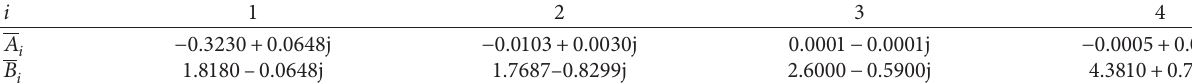
B i and i in equation (17) under ocean current.